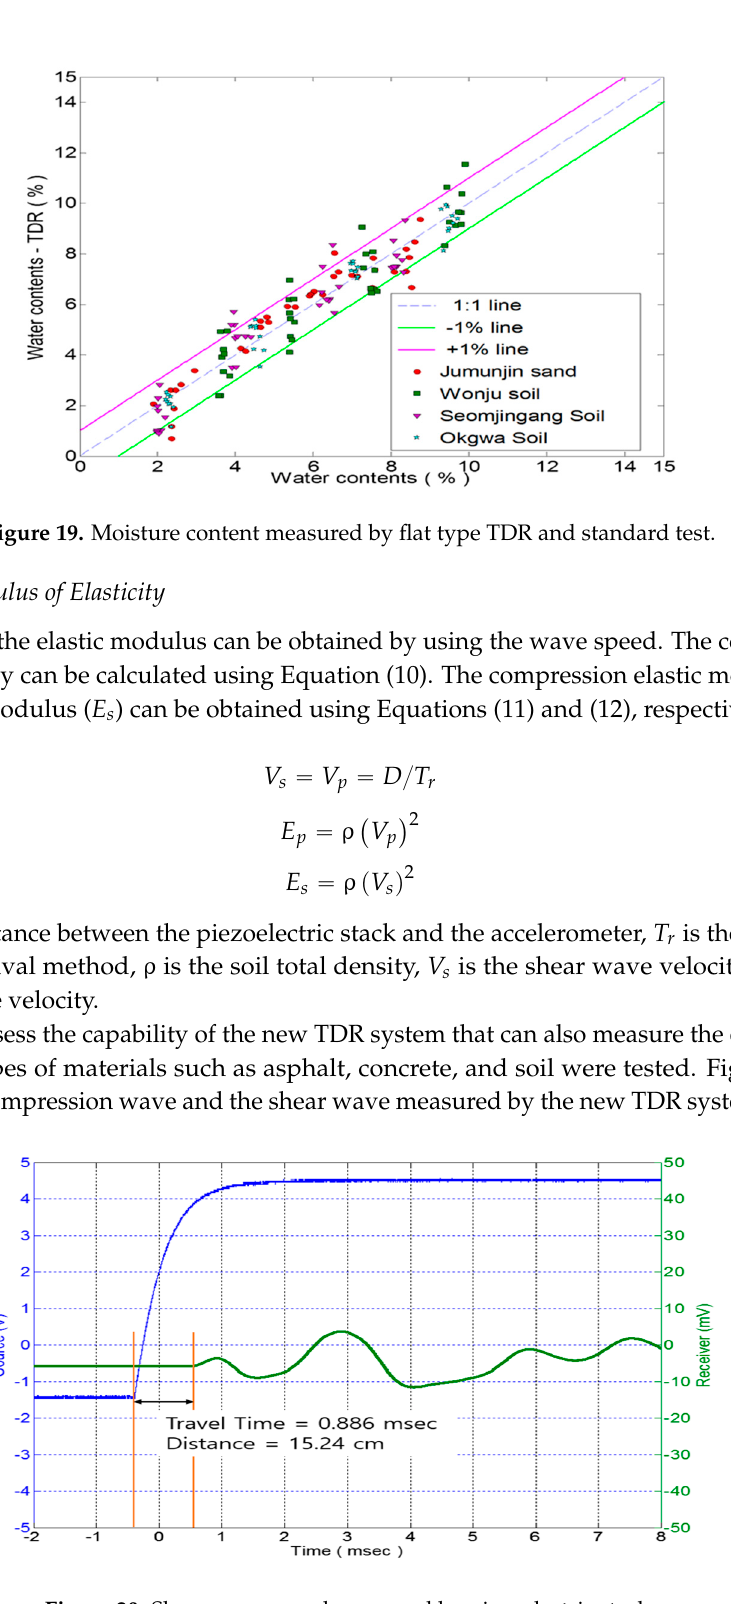
Figure 20. Shear wave speed measured by piezoelectric stack.